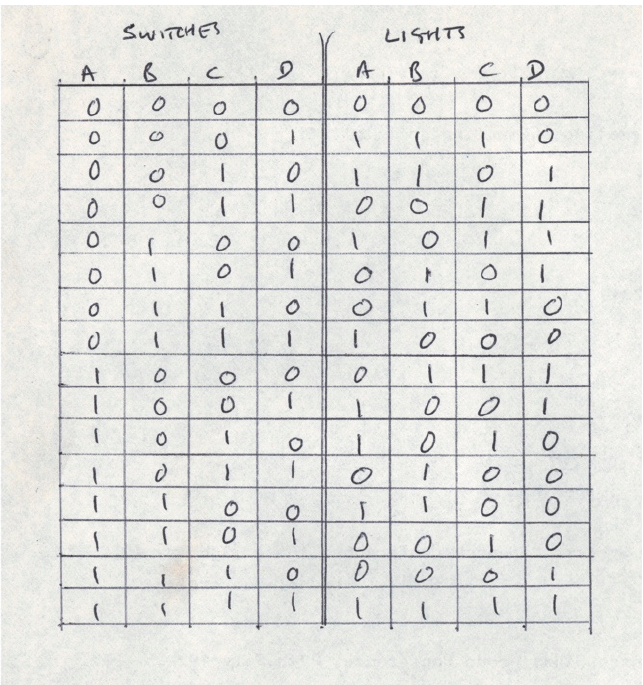
Figure 1. Truth table drawing, Communications Game (c. 1970), © Ernest Edmonds.